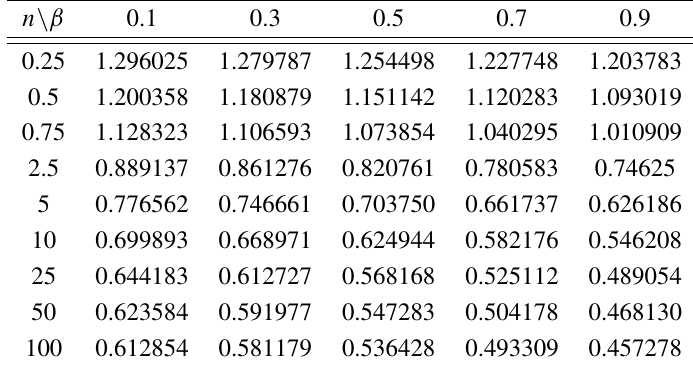
Figure 8. The effect of the surface temperature constant k on temperature profiles when n D 1; ˇ D 0:6; (cid:21) 1 D (cid:21) 2 D 0:5; P r D 3 and E c D 0:5 (a) for PST and (b) PHF cases. Table 2. Numerical values of (cid:0) (cid:18) 0 .0/